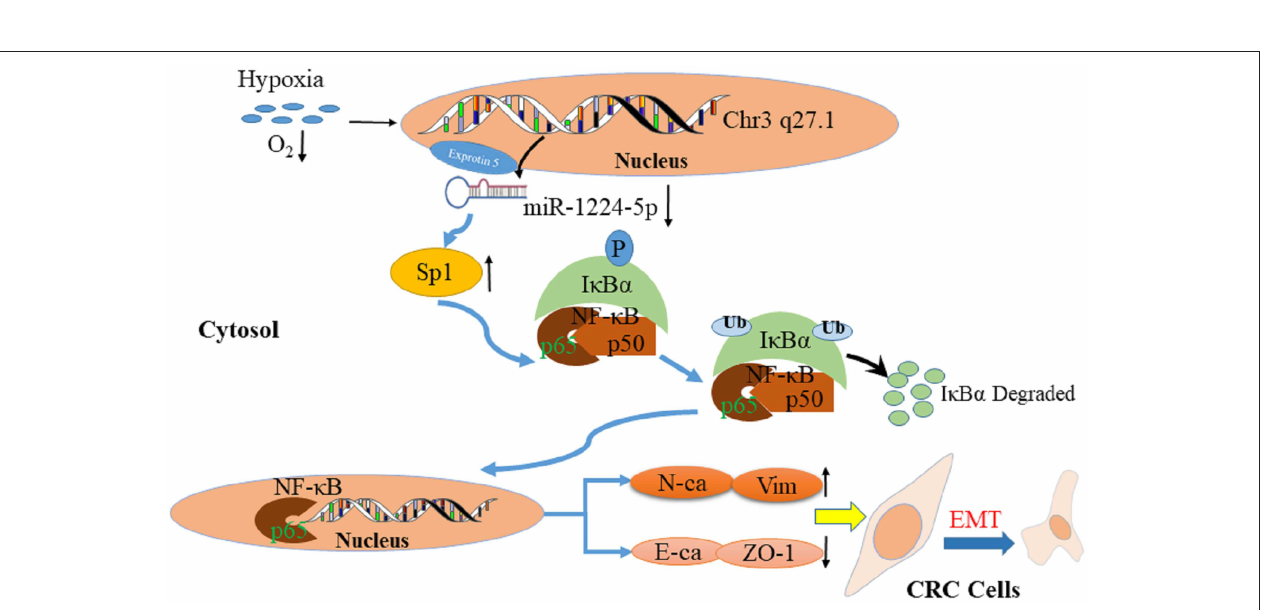
FIGURE 11 | Proposed model of miR-1224-5p-induced EMT via targeting SP1-mediated NF- κ B signaling pathway in CRC cells.